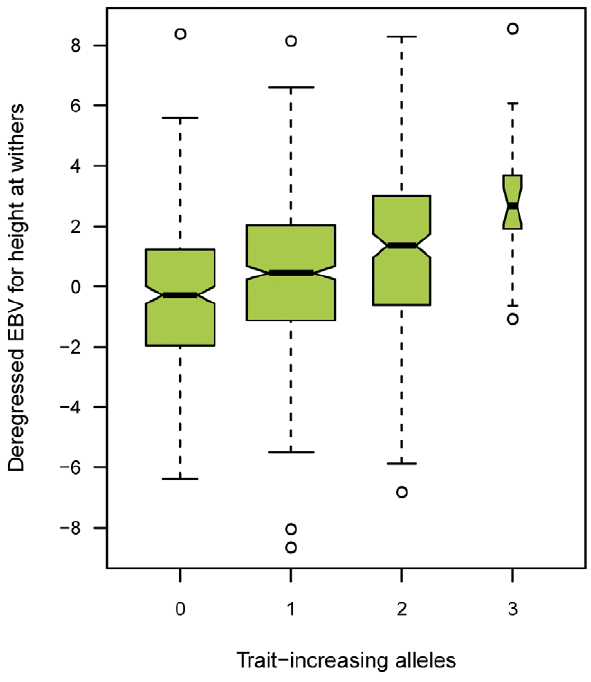
Figure 3. Combined effect size of the two identified QTL on ECA 3 and ECA 9 on the dEBV for height at withers in the FM horse breed. The box plot indicates the median values, 25% and 75% quartiles and the outliers of the distribution. A total of 308, 513, 211, and 21 animals, respectively, represented the classes from zero to three trait-increasing alleles. The difference in the medians between horses with zero and three trait-increasing alleles, respectively, is 2.97 cm. None of the analyzed horses carried four trait-increasing alleles. The association between the number of trait increasing alleles and height at withers is highly significant (p=8.4 6 10 2 13 ; Kruskal-Wallis test). Medians are significantly different between groups.